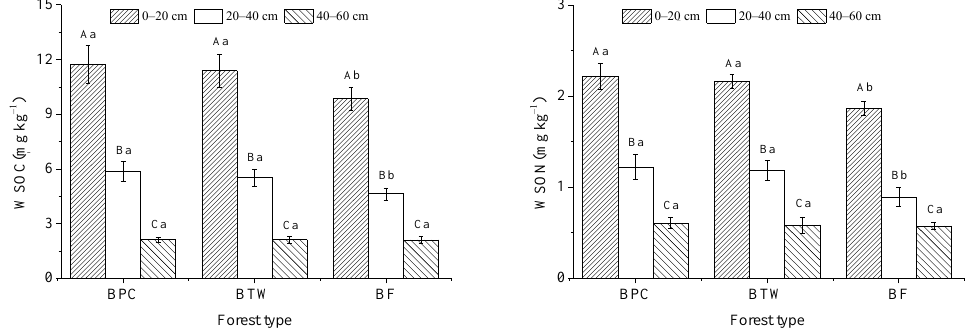
Figure 3. WSOC and WSON concentrations in BPC, BTW, and BF. Capital letters indicate the differences between different soil depths in the same forest type, and lowercase letters indicate the differences between different forest types at the same soil depth. BF, BPC, and BTW represent pure moso bamboo forest, bamboo forest interplanted with Phoebe chekiangensis , and bamboo forest interplanted with Taxus wallichiana var. maireii, respectively.